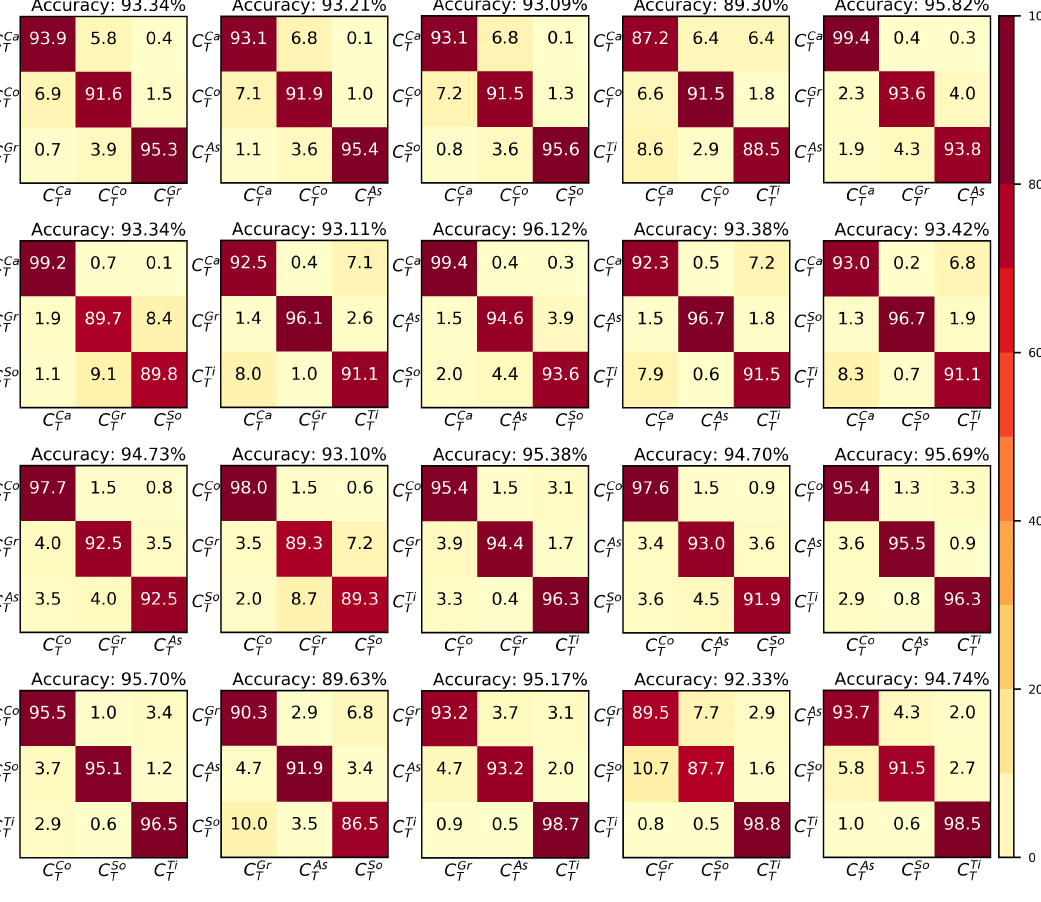
= carpet , C Co = concrete , T T